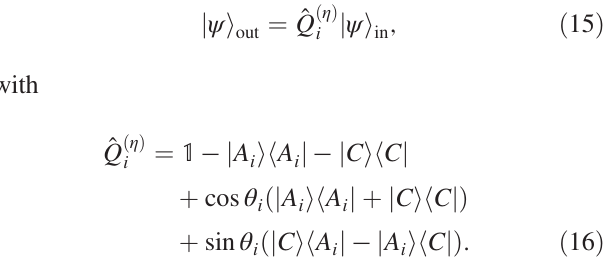
FIG. 4. (a) Representation of a general PDC process. The leftmost panel shows the JSA f ð ω envelope function (black solid lines) and the phase-matching function (black dashed lines). This function is decomposed into two sets of ffiffiffiffiffi p λ TMs f f ð s Þ ð ω and f f ð i Þ ð ω with weighting coefficients . In the central part, we plot the first three TM pairs. The rightmost panel ffiffiffiffiffi s Þg i Þg k p λ shows the distribution of expansion coefficients . (b) A dispersion-engineered PDC process excites only one pair of TMs. The JSA k does not exhibit any correlations between signal and idler photons. The distribution of weighting coefficients only a single entry greater than